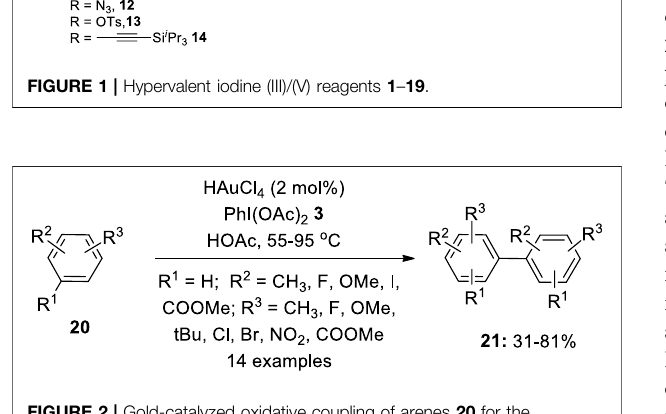
FIGURE 2 | Gold-catalyzed oxidative coupling of arenes 20 for the synthesis of biaryls 21 using PhI(OAc) 2 3 as an oxidant.